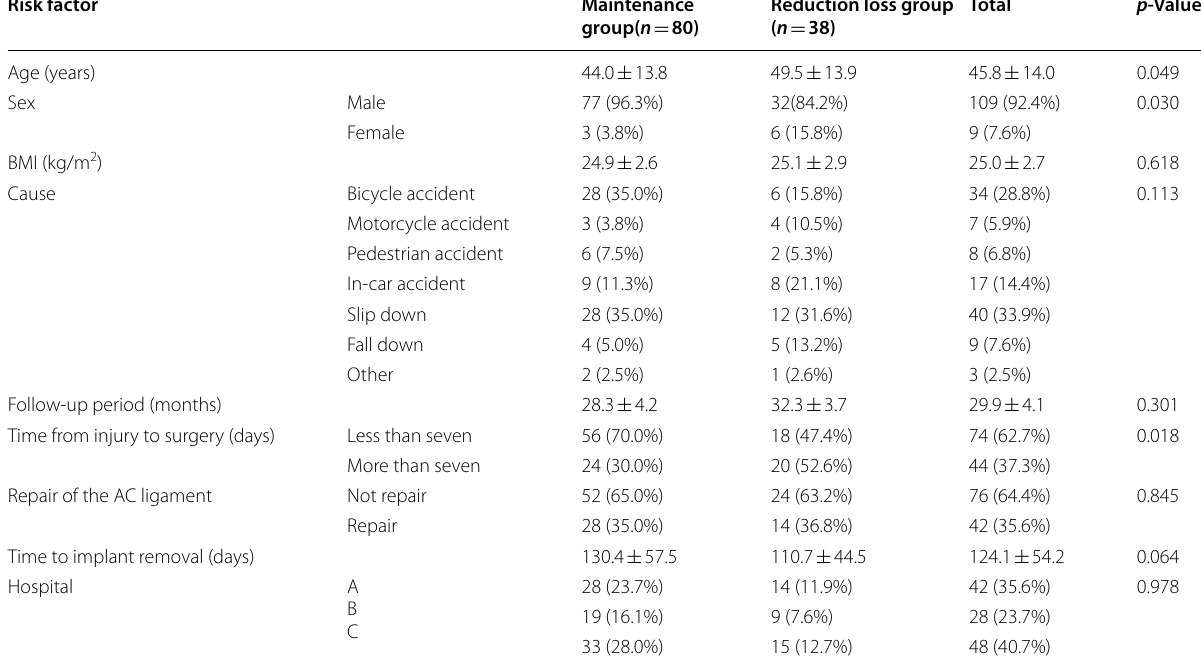
Data are presented as number (percentage) or mean